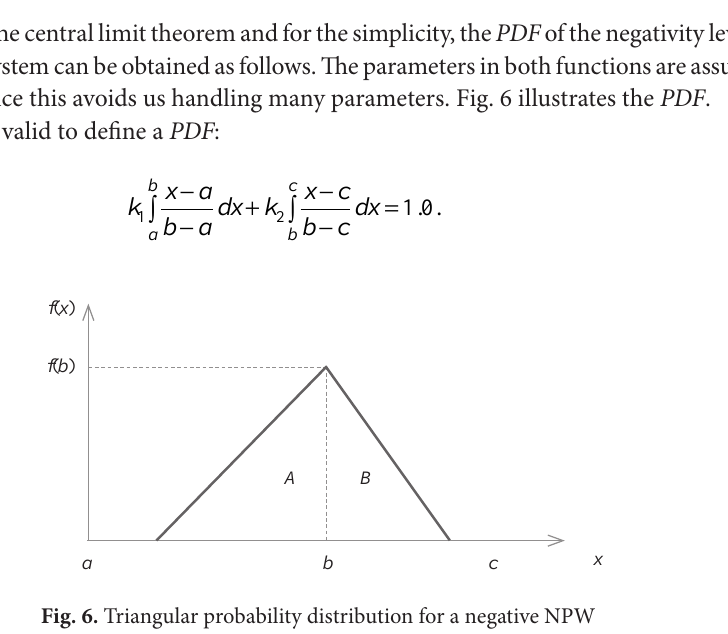
Fig. 6. Triangular probability distribution for a negative